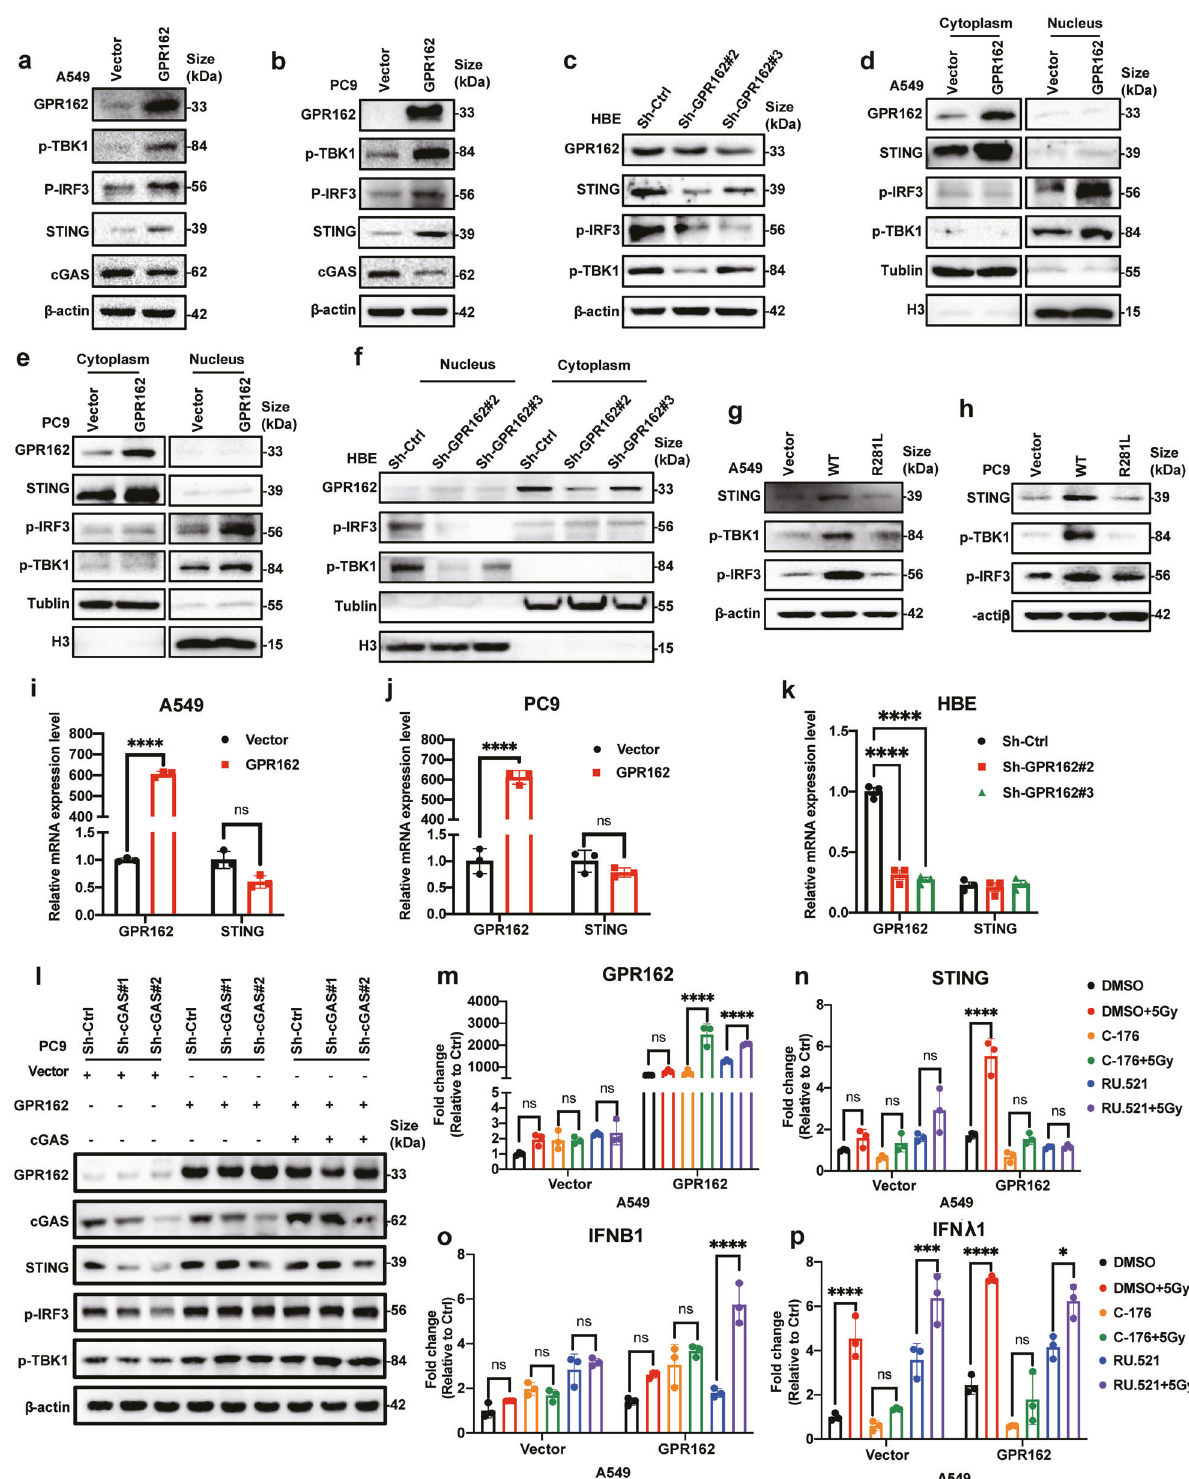
Fig. 2 GPR162 activates the STING signaling pathway independent of cGAS. a – c STING, p-TBK1, p-IRF3, and cGAS expression levels were determined by western-blot analysis in A549 ( a ), PC9 ( b ), and HBE ( c ) cells following GPR162 overexpression or depletion. d , f STING, p-TBK1, and p-IRF3 expression levels were determined by western-blot analysis in nuclear and cytosolic fractions generated from A549 ( d ), PC9 ( e ), and HBE ( f ) cells following GPR162 overexpression or depletion. g – h Western-blot analysis was used to evaluate the protein levels of GPR162 and STING-related genes following STING R281L mutation in A549 ( g ) and PC9 ( h ) cells. i – k qPCR analyses of STING in A549 ( i ), PC9 ( j ), and HBE ( k ) cells after overexpressing or depletion GPR162. l The protein levels of STING and its downstream associated components were detected by western-blot in cGAS knockdown PC9 cells following GPR162 overexpression and exogenously introduced cGAS. m – p qPCR analysis of GPR162 ( m ), STING ( n ), IFNB1 ( o ), and IFN λ 1 ( p ) in A549 cells treated with IR by cGAS and STING inhibitors after overexpressing GPR162. (* p < 0.05, *** p < 0.001, **** p < 0.0001) Signal Transduction and Targeted Therapy (2023)